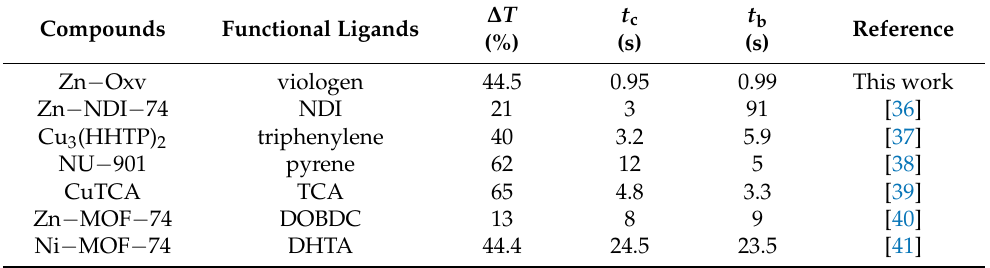
Table 1. Comparison of EC properties of Zn − Oxv films and other CP films based on functional ligands.